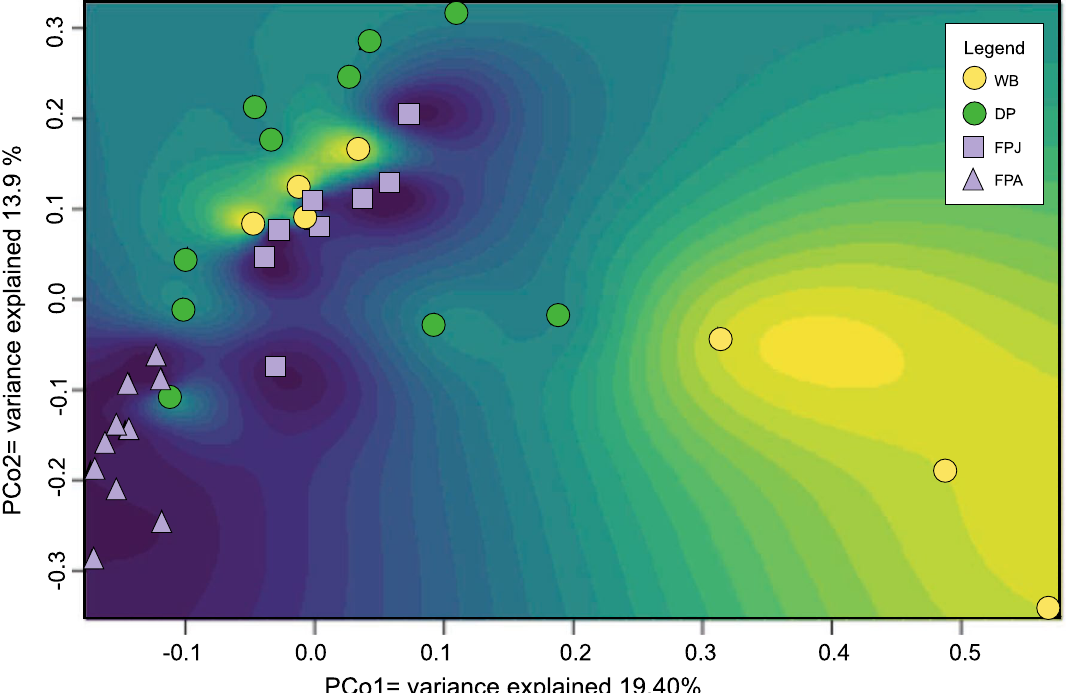
Fig. 4 Principal Coordinate Analysis (heatmap PCoA) plot generated based on Bray–Curtis. Each point represents the intestinal microbiota of an individual. A buffer was generated around each of the microbial communities to characterize the multivariate space. Wild boar, WB; domestic pig, DP; juvenile feral pig, FPJ; adult feral pig,